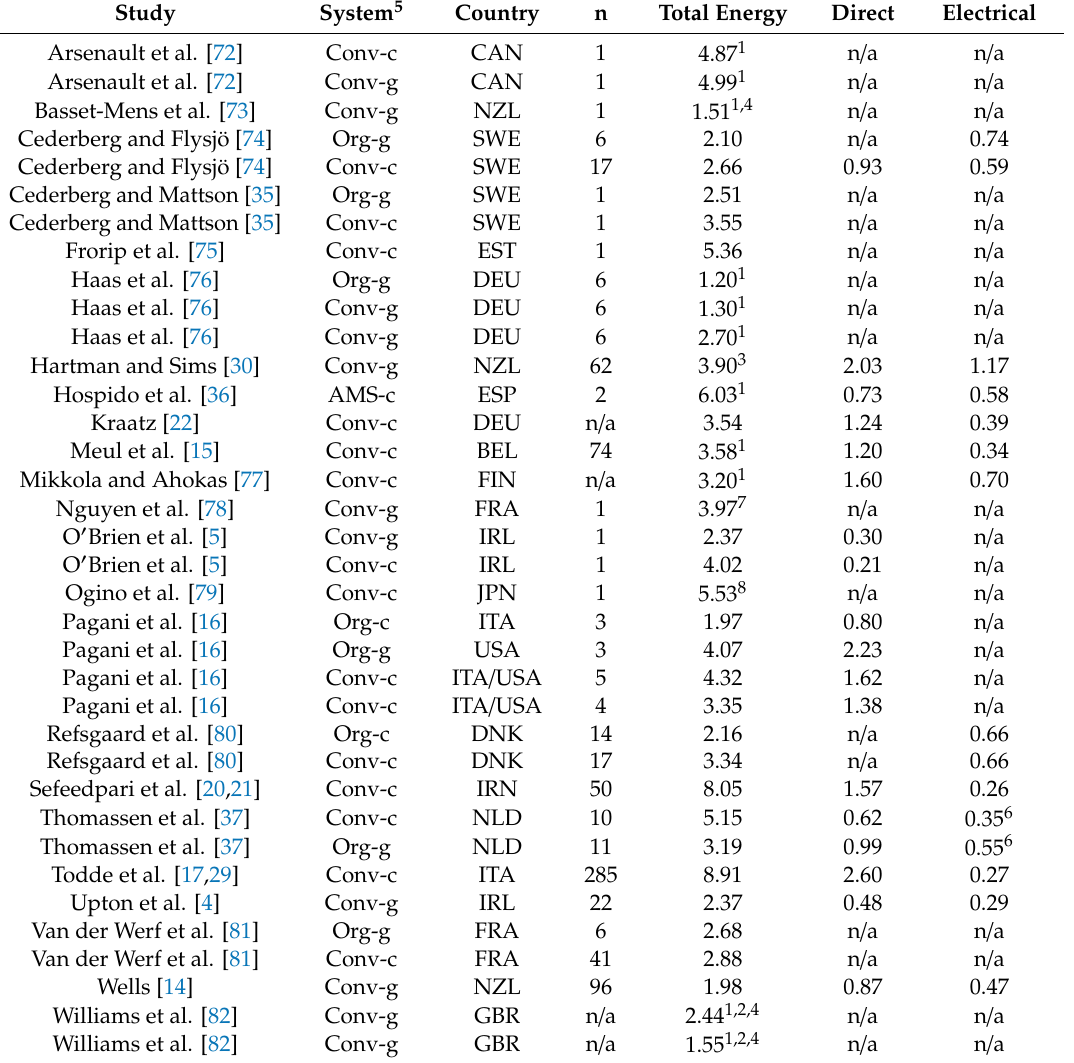
Table A1. Energy consumption (MJ kg − 1 ECM unless stated otherwise) values found in literature.